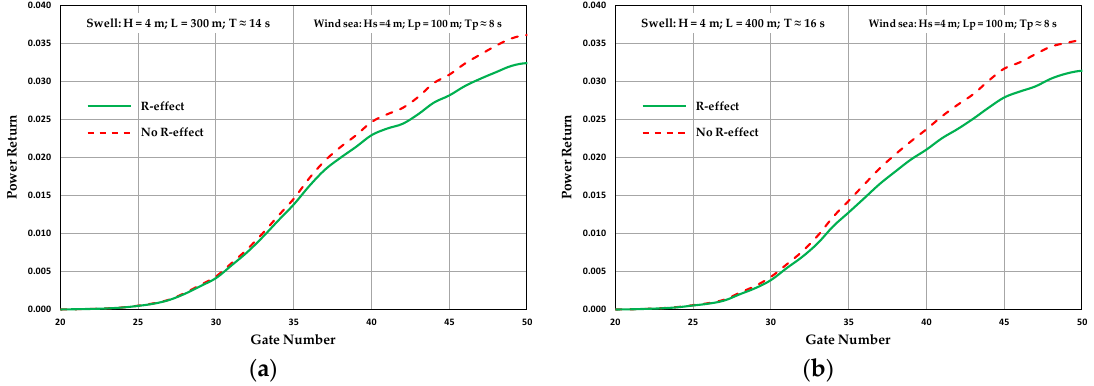
Figure 10. Comparison between averaged 20 Hz WF with (green line), and without (dashed red line), R-effect for swell superimposed to a wind sea: ( a ) JONSWAP significant wave height Hs = 4 m, peak wave period Tp = 8 s; swell wave height H = 4 m, period T = 14 s; ( b ) JONSWAP significant wave height Hs = 4 m, peak wave period Tp = 8 s; swell wave height H = 4 m, period T = 16 s.